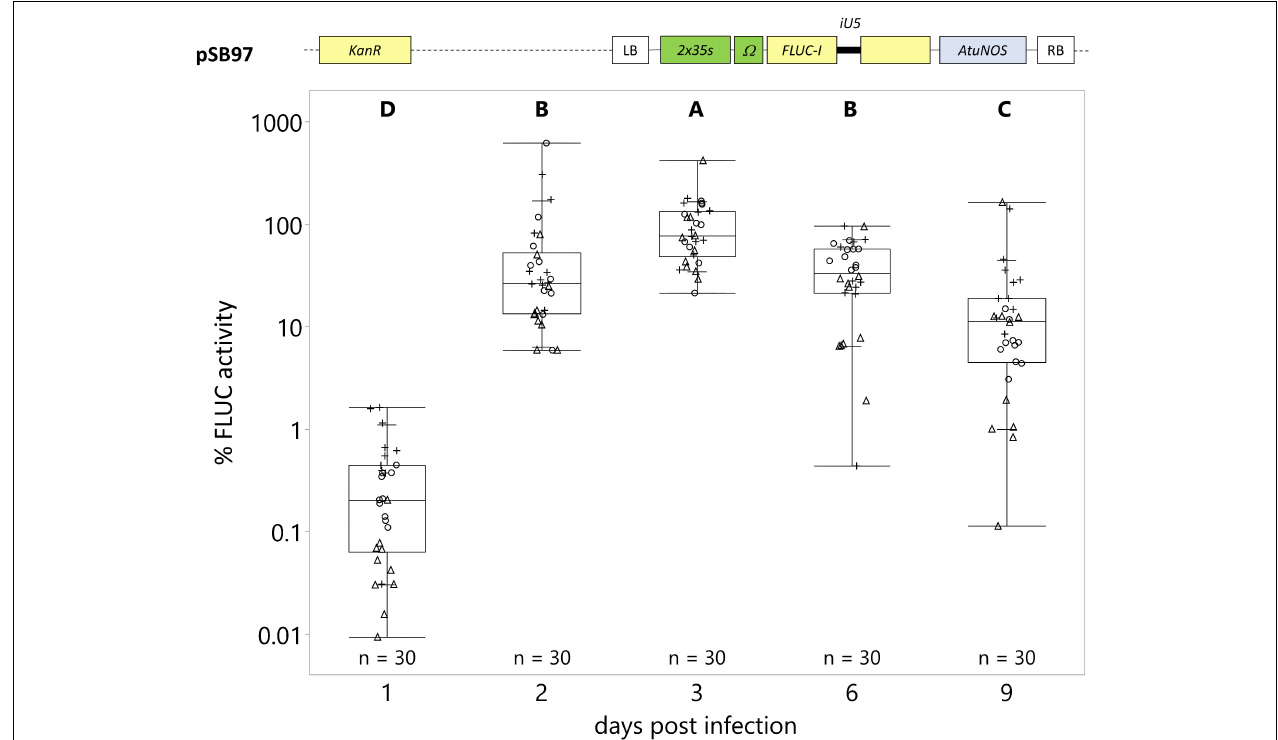
FIGURE 3 | Strongest transgene expression is detected in seedlings 3 days post-infection (dpi). C. roseus seedlings (10-days-old) were vacuum infiltrated with A. tumefaciens containing the FLUC-I reporter (plasmid pSB97) at OD 600 = 0.2. Samples were taken 1, 2, 3, 6, and 9 dpi. FLUC activity was normalized to protein content. The average FLUC activity to protein content of samples collected at 3 dpi was used as reference (set to 100%) to determine the relative FLUC activity of each sample. The experiment was carried out in three independent assays (represented by the + , (cid:13) , (cid:49) symbols). The box plot horizontal line shows the median, ends of the boxes show interquartile range, small marks show the 10th and 90th quantile and whiskers show lowest/highest data point. Different letters indicate values that are significantly different (Tukey-Kramer HSD test on log-transformed data, p < 0.05).